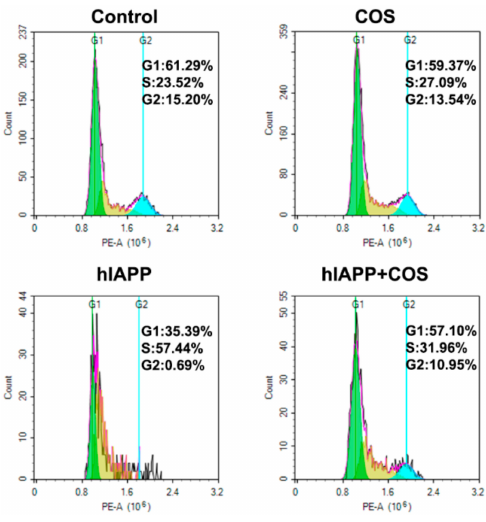
Figure 7. The e ff ect of COS on hIAPP-induced cycle arrest in β -TC-6 cells. The G1, S and G2 phases in cell cycle are represented by green, yellow, and blue, respectively. The cells were exposed to 50 µ M hIAPP in the presence or absence of 2.0 mg / mL COS for 24